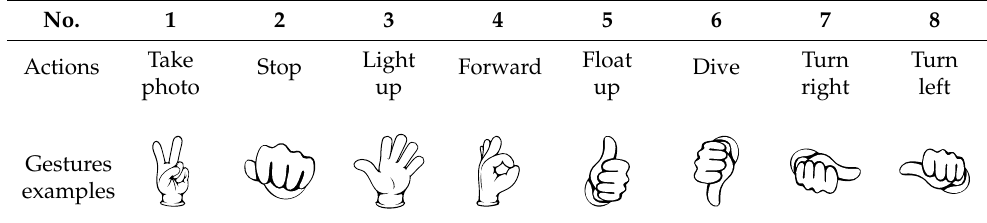
Table 1. Gestures corresponding to robot actions.